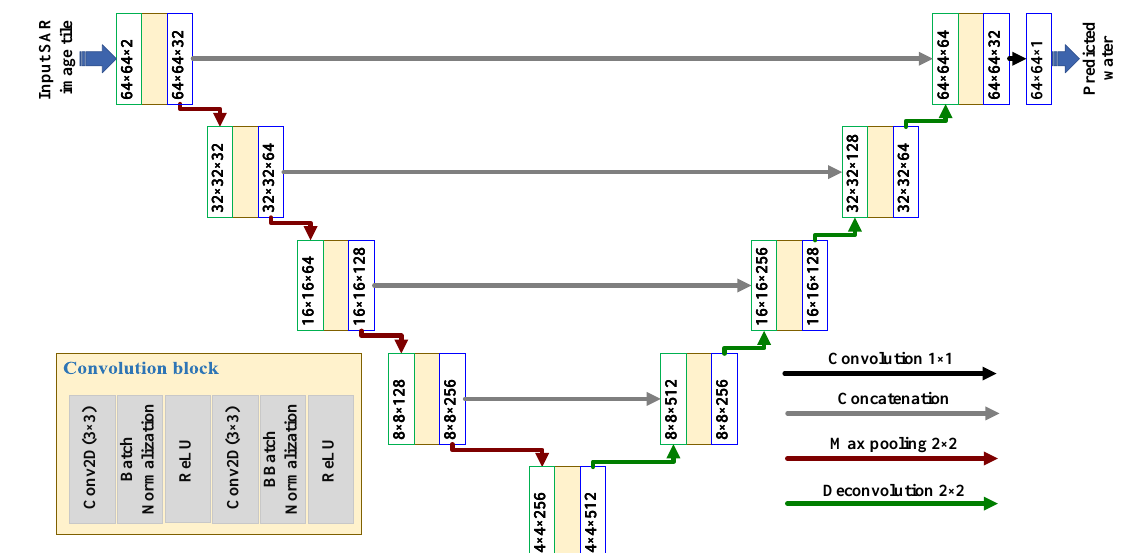
Figure 7. The WaterUNet structure for water extraction (total params: 7,771,585; trainable params: 7,765,697; non-trainable params: 5888) The numbers in the green box are for the input dimension of the convolution block and the numbers in the blue box are for the output dimension.